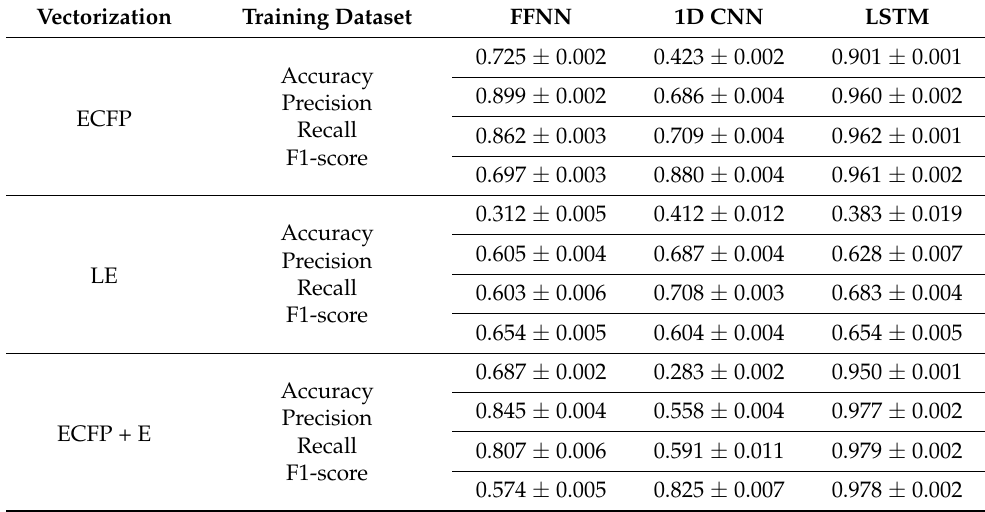
Table 5. Evaluation results of task No.